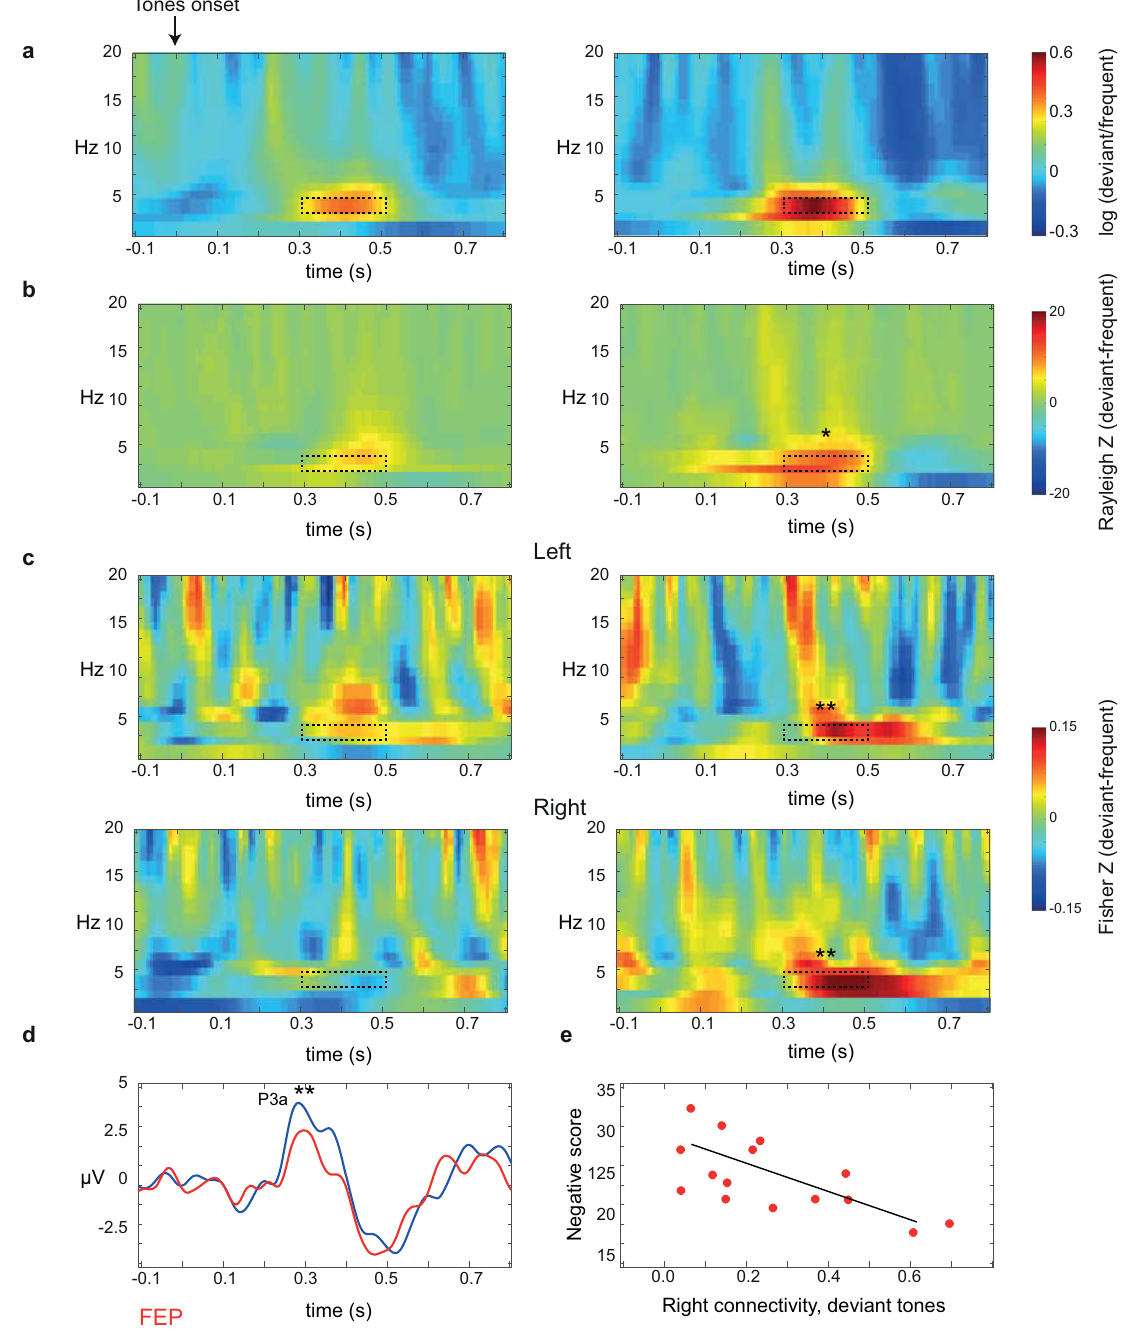
Fig. 2 Theta oscillations differences (deviant - frequent) in each group. a TFR of power. b PLF. c Left (F7-P7) and right (F8-P8) fronto-parietal connectivity. d ERP (P3a). e Lower right theta connectivity for deviant tones was associated with higher scores of negative symptoms ( p = 0.007). Dashed rectangles indicate time-frequency ranges of interest. Asterisks indicate signi fi cant differences between tone types (only present in the HC group). * p < 0.05, ** p ≤